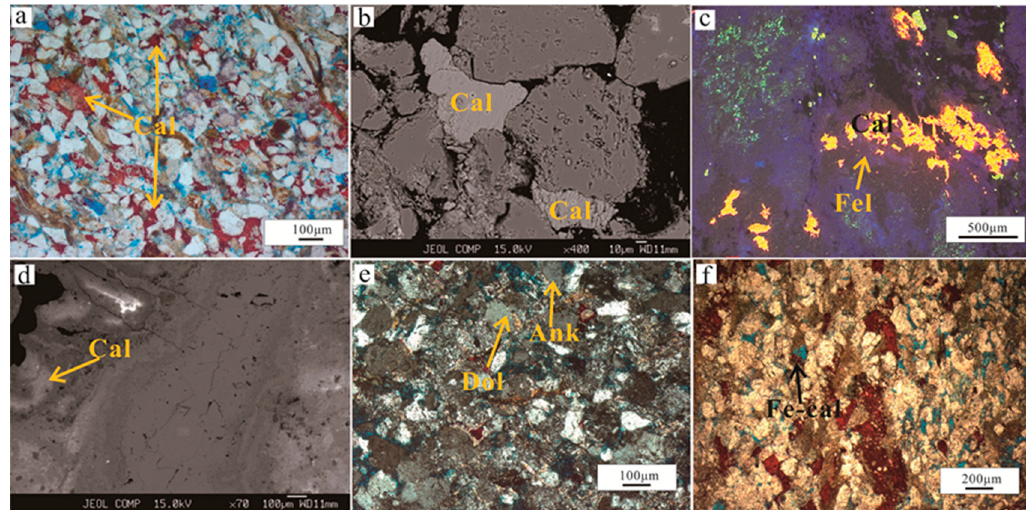
Figure 8. Photomicrographs showing the characteristics of carbonate cementation ( a ) Dense micritic texture calcite (Ca-II) filled the gaps between tightly packed grains and covers and engulfs quartz overgrowths (yellow arrow), PPL. ( b ) Backscattered electron (BSE) image of isolated pore-filling carbonate cement. ( c ) CL image showing calcite cements locally replacing feldspar. ( d ) BSE image showing pore-filling calcite cements appear in a circular band. ( e ) Dolomite and ankerite cement occur mainly as isolated rhombic and euhedral rhombs crystals, respectively. ( f ) Ferrocalcite filling in feldspar dissolution pores and replace detrital grains (black arrow), PPL. Cal: calicite; Fel: